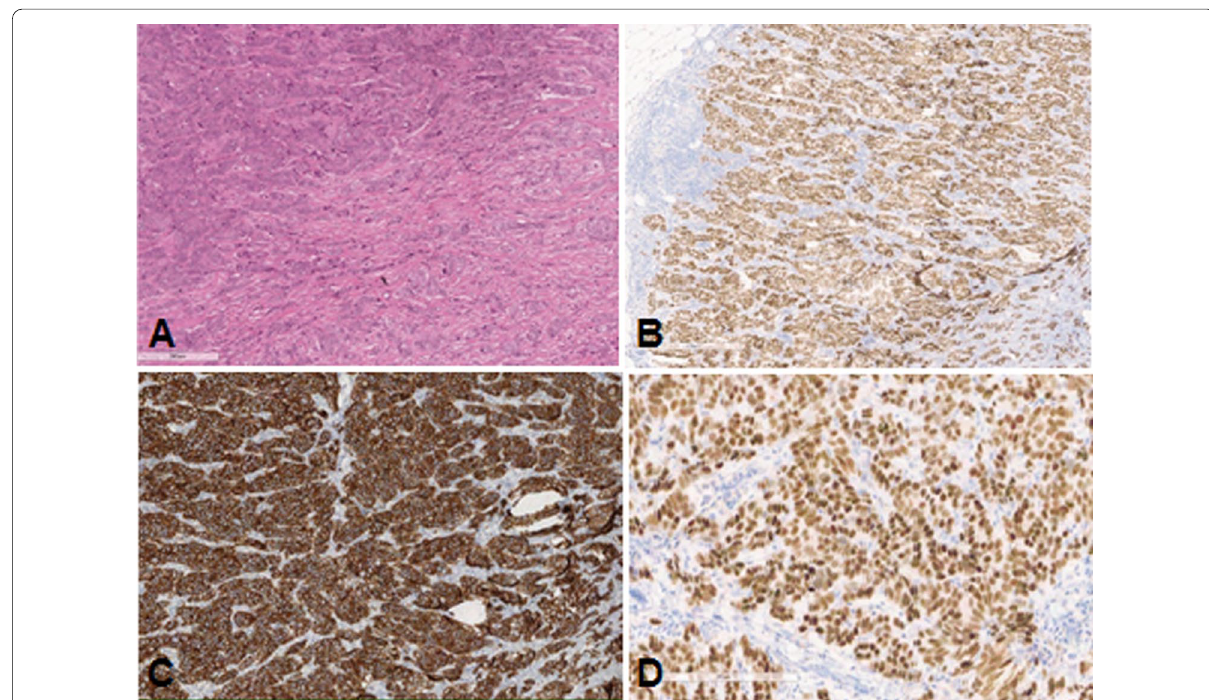
Fig. 4 showing histopathology and immunochemical stains of an internal mammary lymph node showing metastatic intraductal carcinoma A Hematoxylin and eosin 12